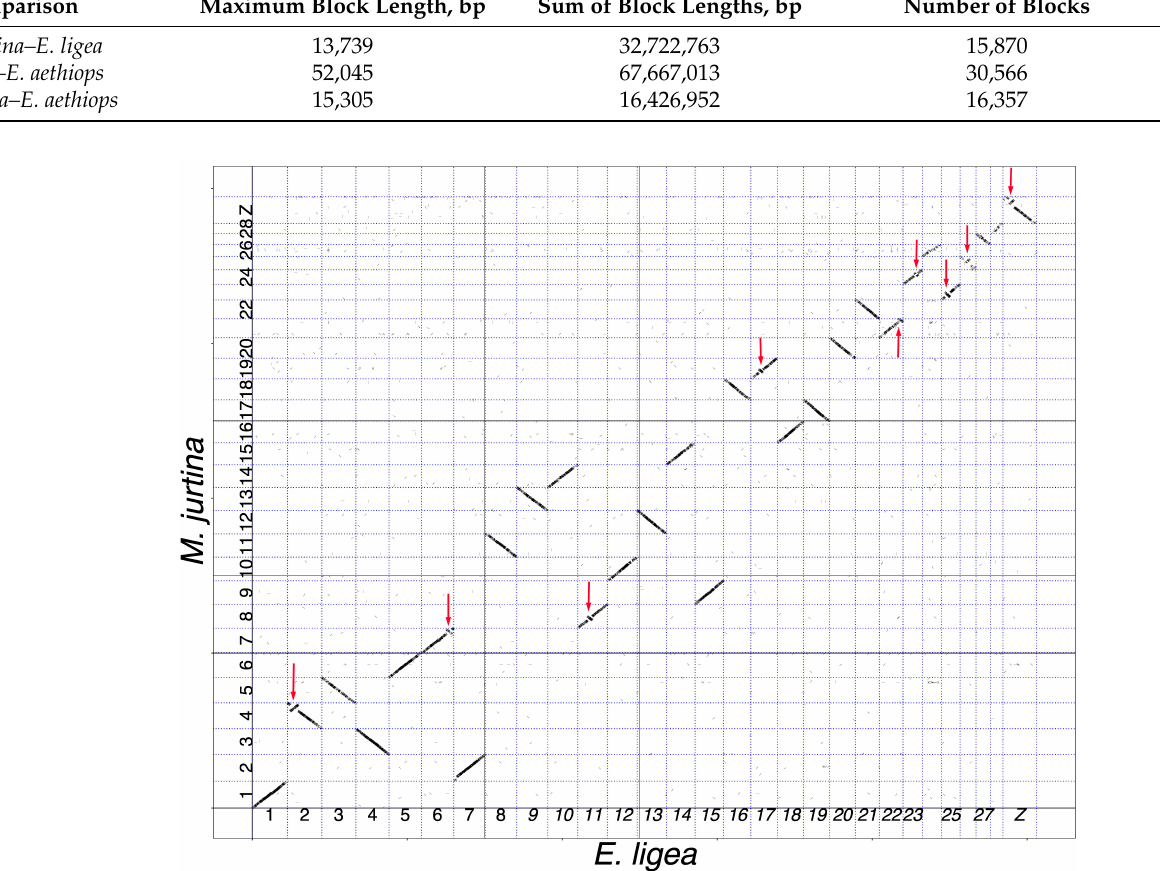
Figure 1. Genome of E. ligea (horizontal axis) plotted against genome of M. jurtina (vertical axis). It can be seen that chromosome 1 ligea corresponds to chromosome 1 jurtina , chromosome 2 ligea corresponds to chromosome 4 jurtina , chromosome 3 ligea corresponds to chromosome 5 jurtina , chromosome 4 ligea corresponds to chromosome 3 jurtina , and so on, and chromosome Z ligea corresponds to chromosome Z jurtina . Each short stroke represents a single syntenic block (a supported alignment), positioned according to its position in the genomes of the compared species. All compared chromosomes are syntenic. Twenty pairs of chromosomes are collinear. Nine pairs of chromosomes show the presence of inversions (shown by red